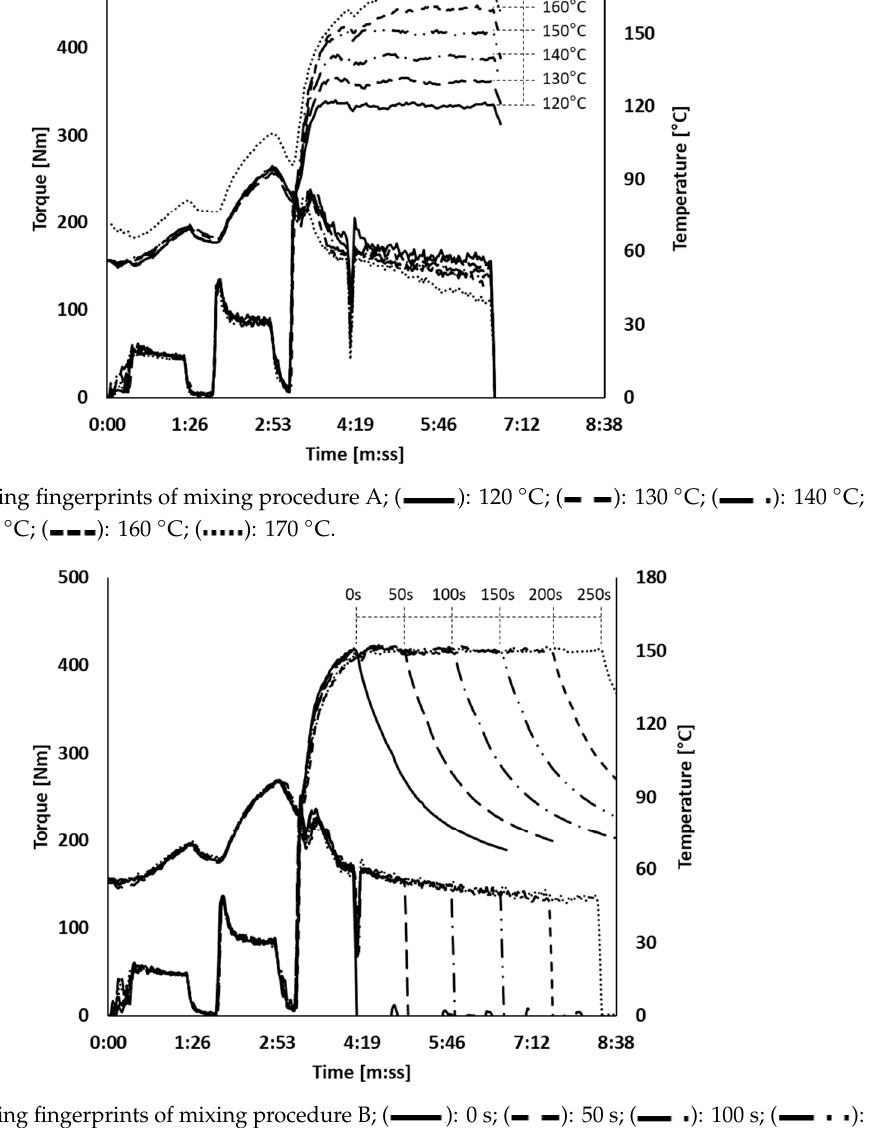
Figure 1. Mixing fingerprints of mixing procedure A; (